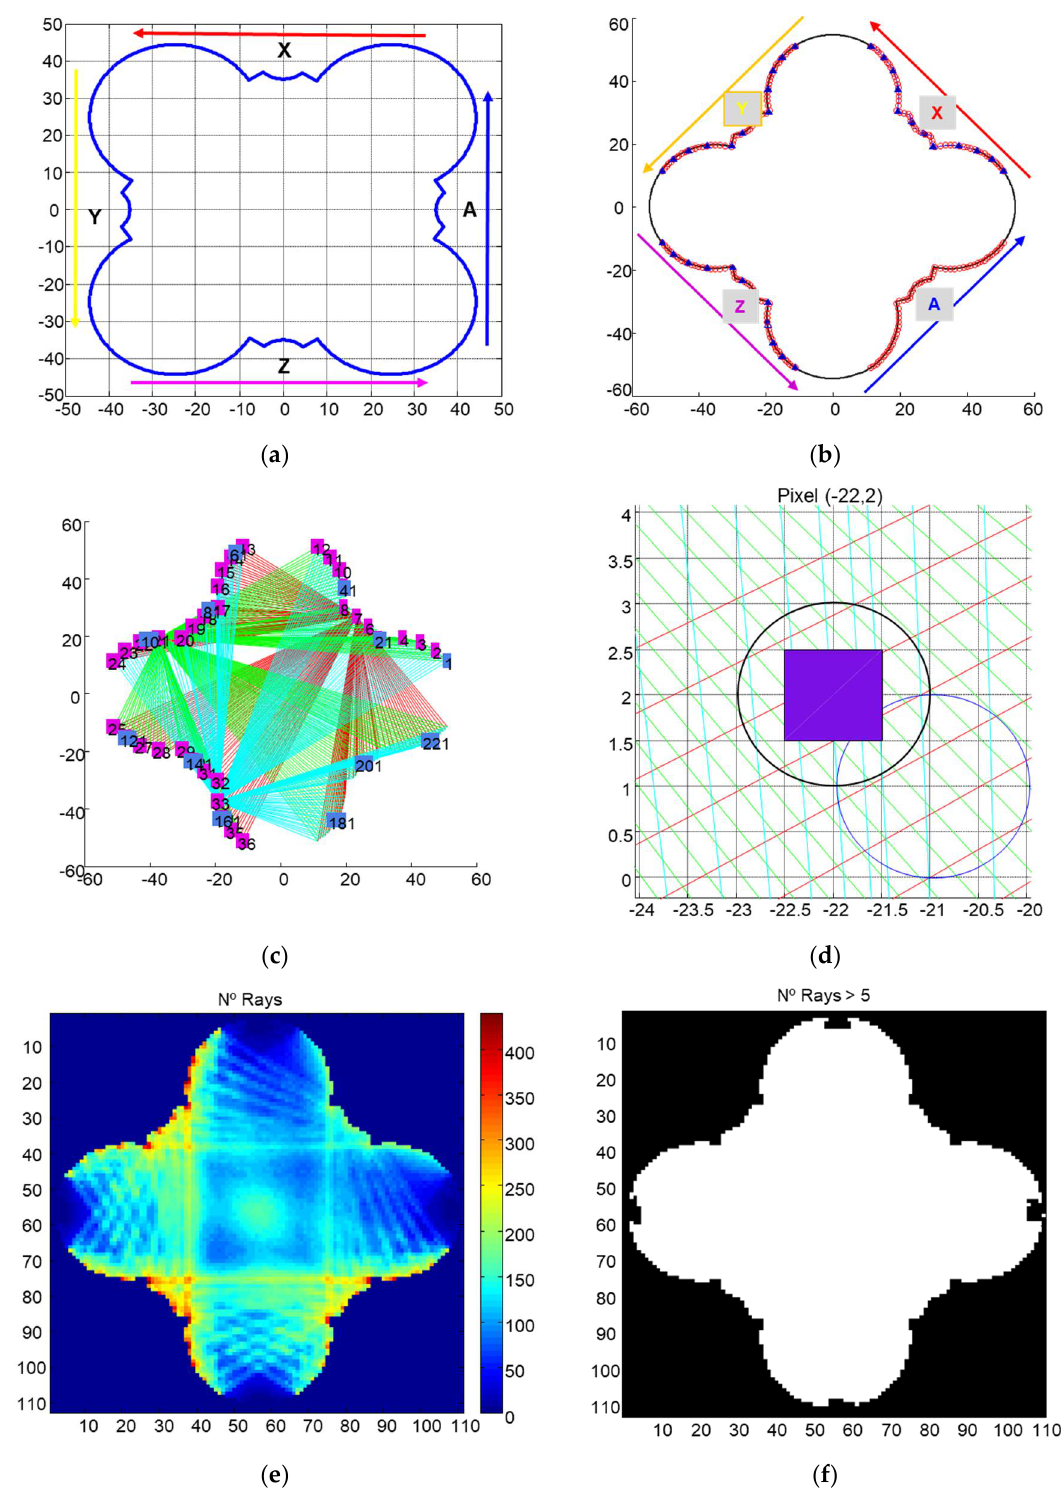
Figure 8. ( a ) Profile of a column cross section with the four axes; ( b ) position of emitters (blue triangles) and receivers (red circles); ( c ) example of generated rays in a cross section; ( d ); schematic representation of projections in a pixel; ( e ) number of rays passing for each pixel; ( f ) pixels with at least 5 rays passing.